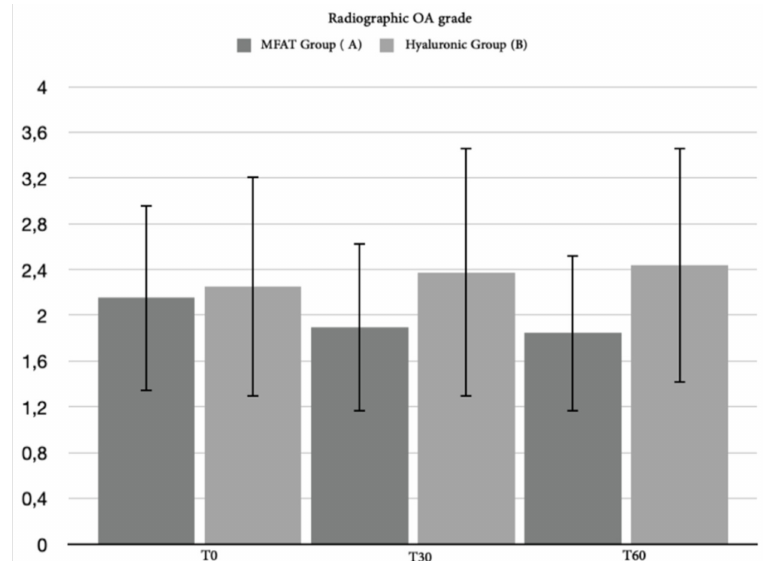
Figure 8. These graphs show the differences in statistical analysis data between hyaluronic group and MFAT group for the radiographic OA grade after 30 days and after 60 days. As shown by the absence of asterisks, no statistical difference between groups, either within groups was highlighted by the statistical analysis.